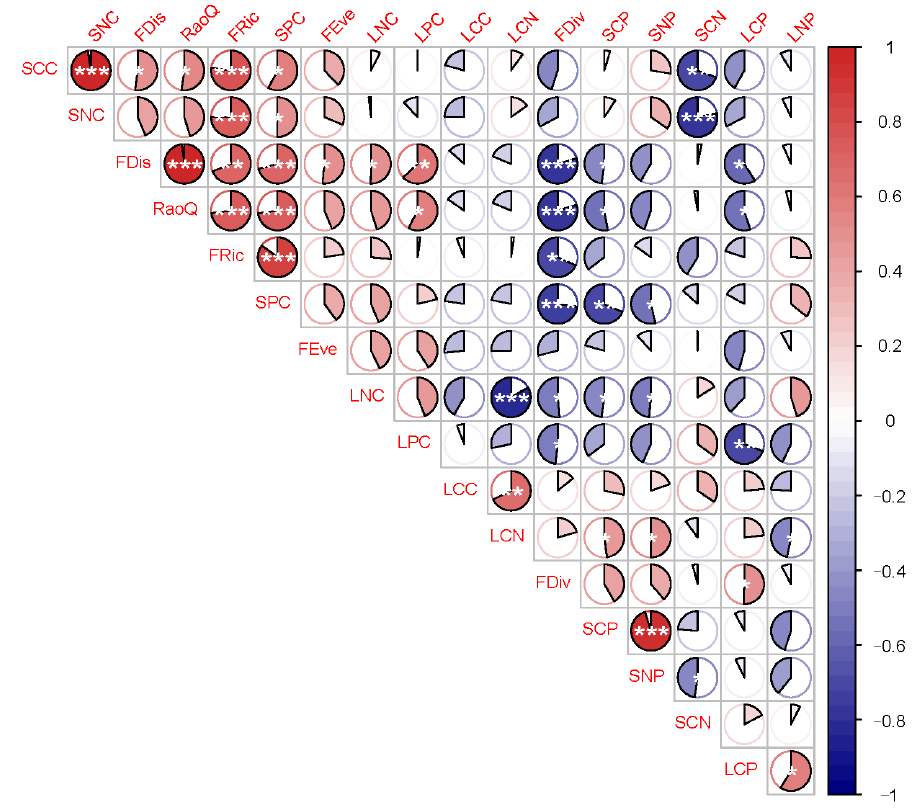
Figure 6. Correlations of functional diversity with leaf and soil chemical properties. SCC—soil or-